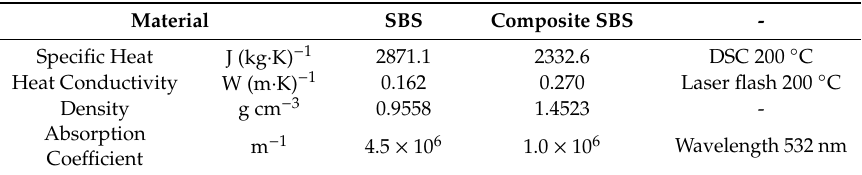
Table 1. Material properties of SBS and composite SBS.